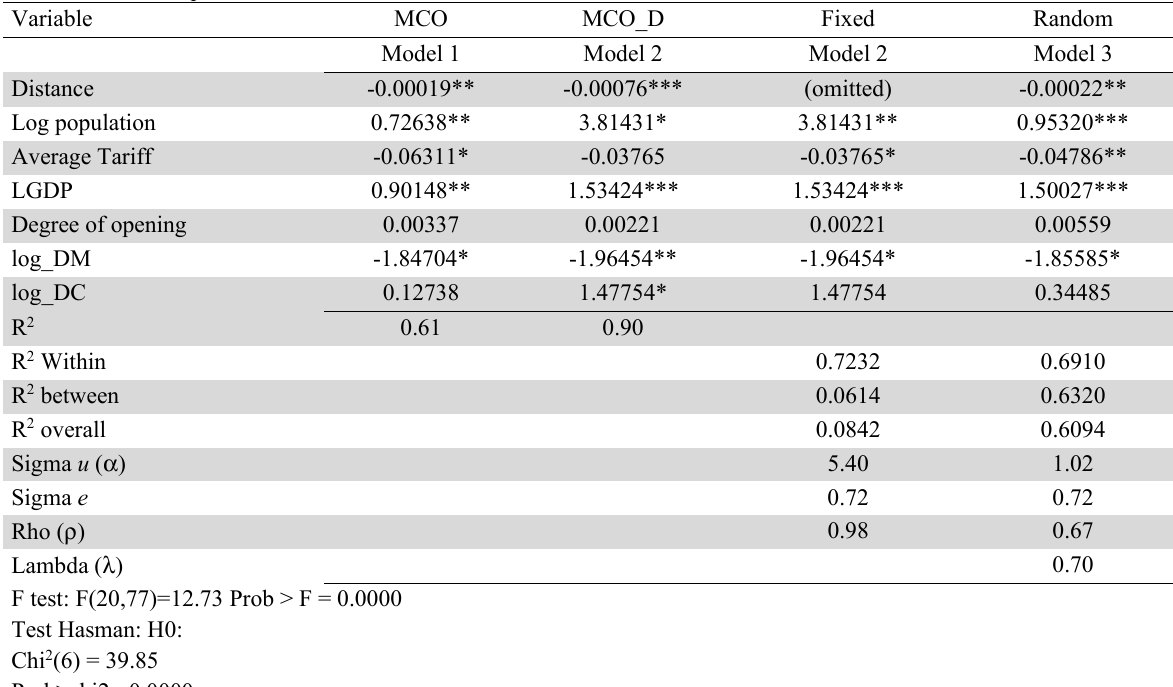
Panel models for